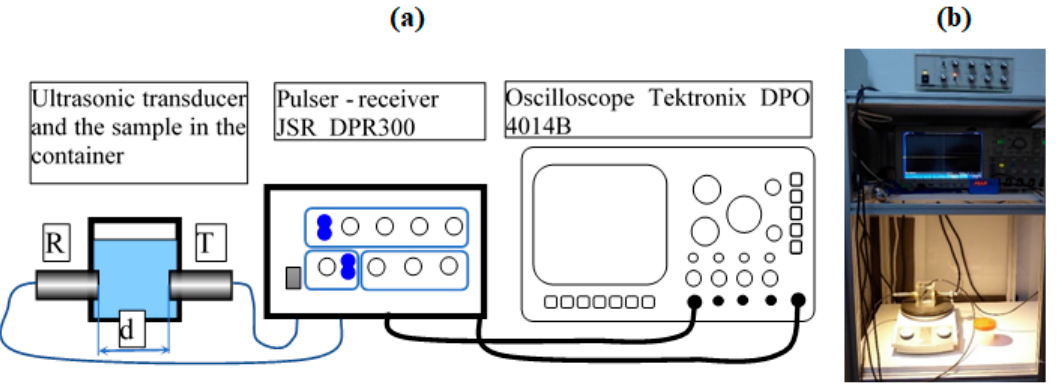
Figure 1. Experimental setup: schematic ( a ) and photo ( b ).